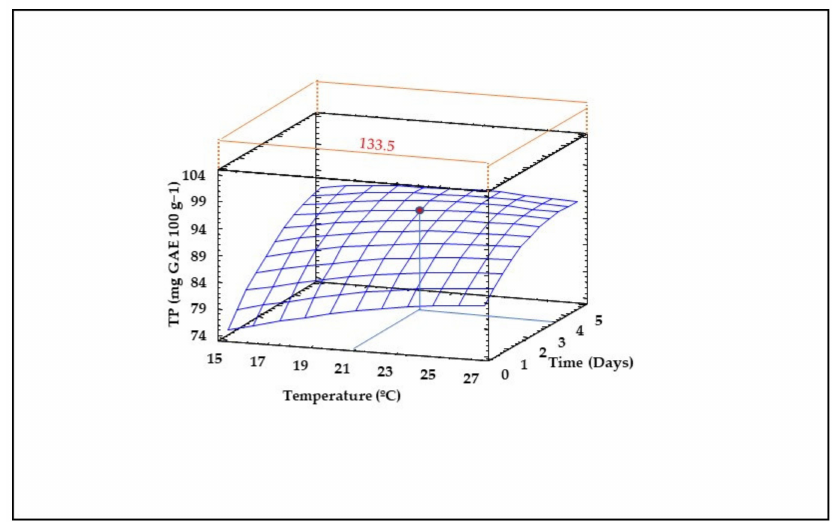
Figure 6. Three-dimensional response surface plots for Total Phenol (TP) as a function of the interaction between germination temperature and time. The red line corresponds with the control (ungerminated seed) and the red point with the value for optimum conditions (21 ◦ C and 3.5